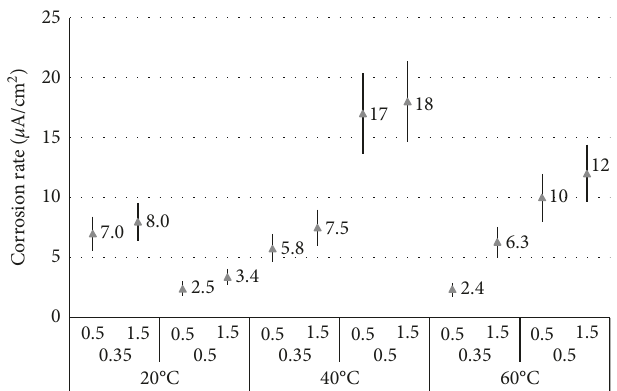
Figure 3: Characteristic values of corrosion intensity.